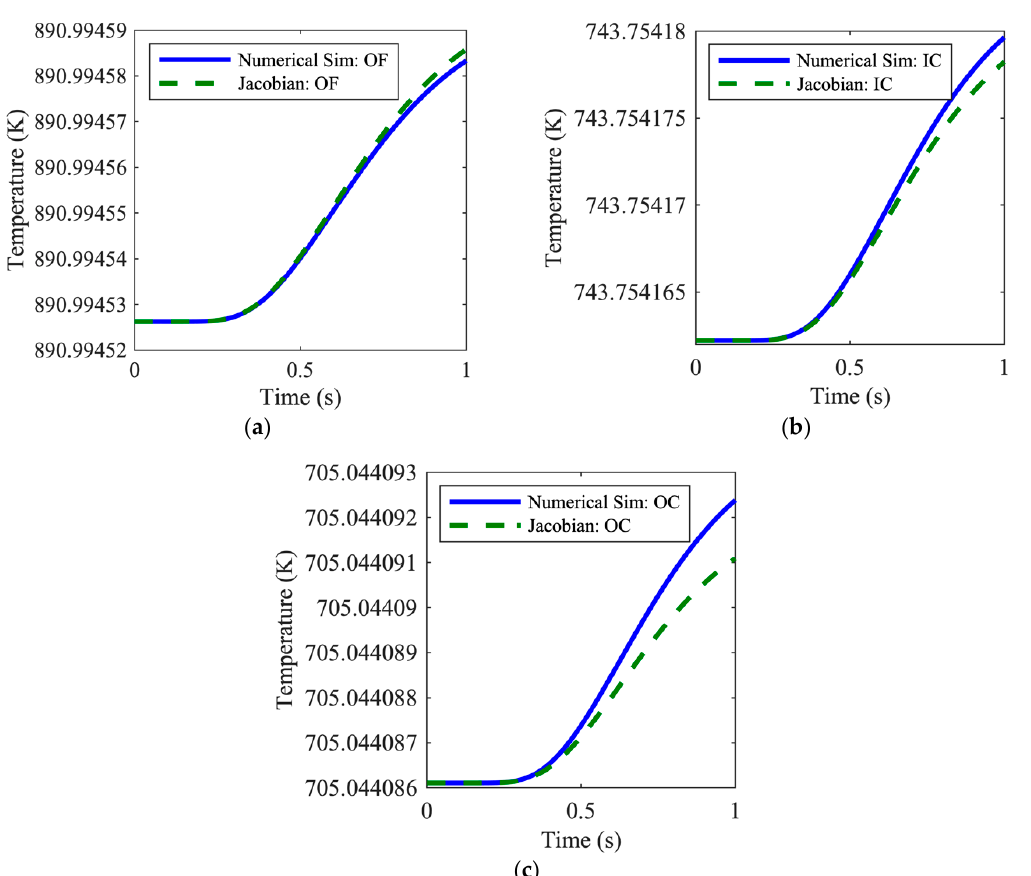
Figure 4. Temperature evolutions at other radial positions (OF = outer fuel, IC = inner cladding, and OC = outer cladding) across from the 1% centerline temperature perturbation. (a) Temperature evolution at the outer fuel node. (b) Temperature evolution at the inner cladding node. (c) Temperature evolution at the outer cladding node.